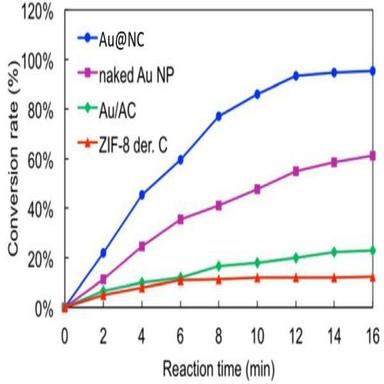
The conversion rate of 4-nitrophenol reduction catalyzed by Au@NC, naked Au nanoparticles derived from Au@NC, Au-loaded activated carbon (Au/AC), and ZIF-8 derived carbon. Reprinted with permission from Ref..